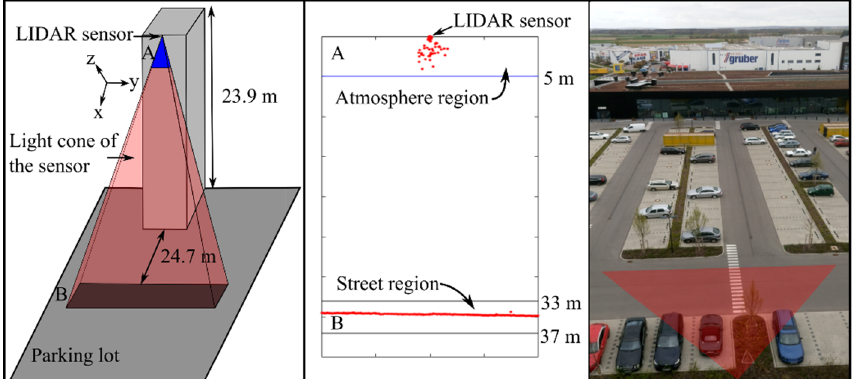
Figure 3. Depiction of the measurement setup. Left: schematic front view of the LIDAR sensor position and its effective field of view (A: atmosphere region, B: street region), the used axis corresponds to the LIDAR coordinate system. Middle: example of the obtained point cloud (birds eye view). Right: Picture from top of the building. The field of view of the sensor is illustrated by the red triangle.